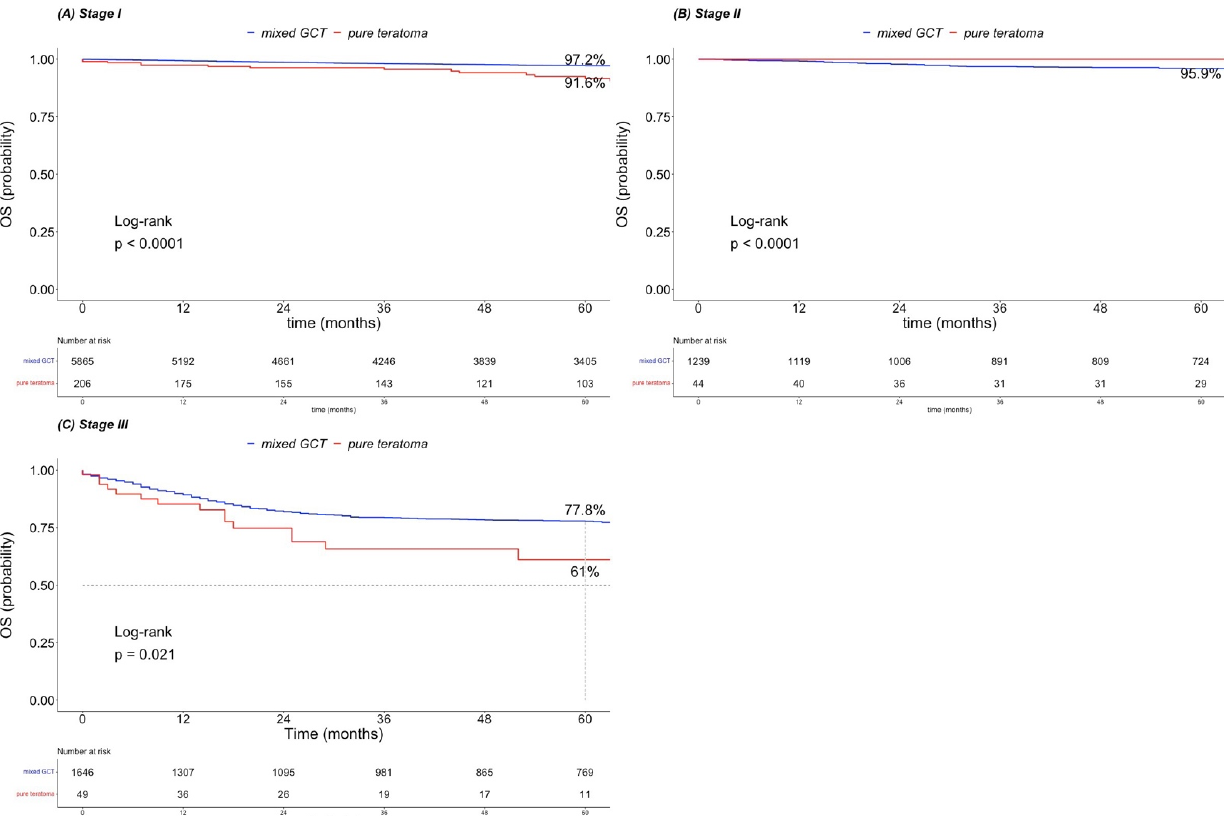
Figure 2. Kaplan–Meier estimates of overall survival (OS) in pure teratoma vs. mixed germ cell tu- mor (GCT) patients according to ( A ) stage I, ( B ) stage II and ( C ) stage III.